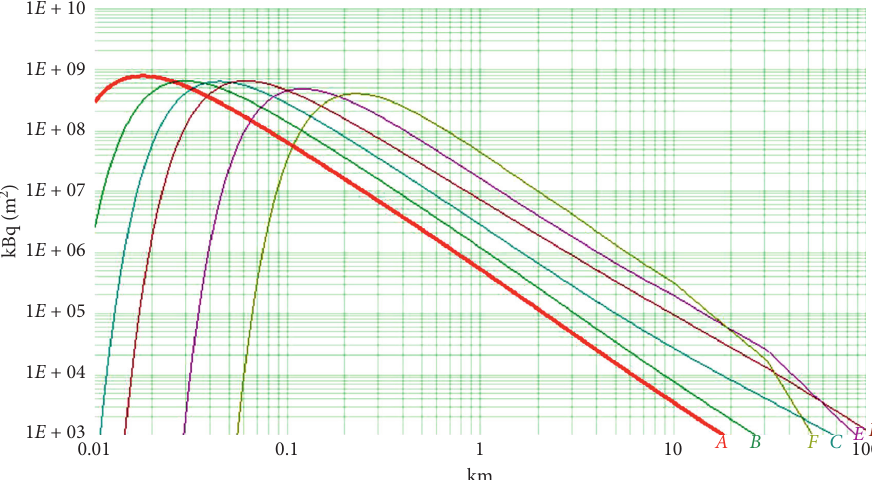
Figure 8: Plume centerline ground deposition (kBq/m 2 ) as a function of distance (km) from the JRTR reactor for different weather stability classes ( A – F